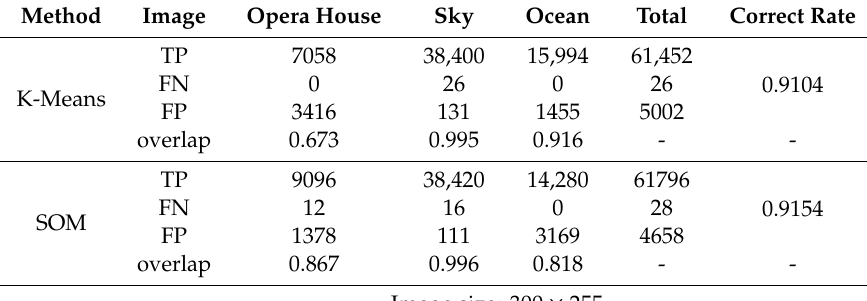
( d ) Figure 15. Segmentation results of an image of the Sydney Opera House. ( a ) Original image. ( b ) Ideal